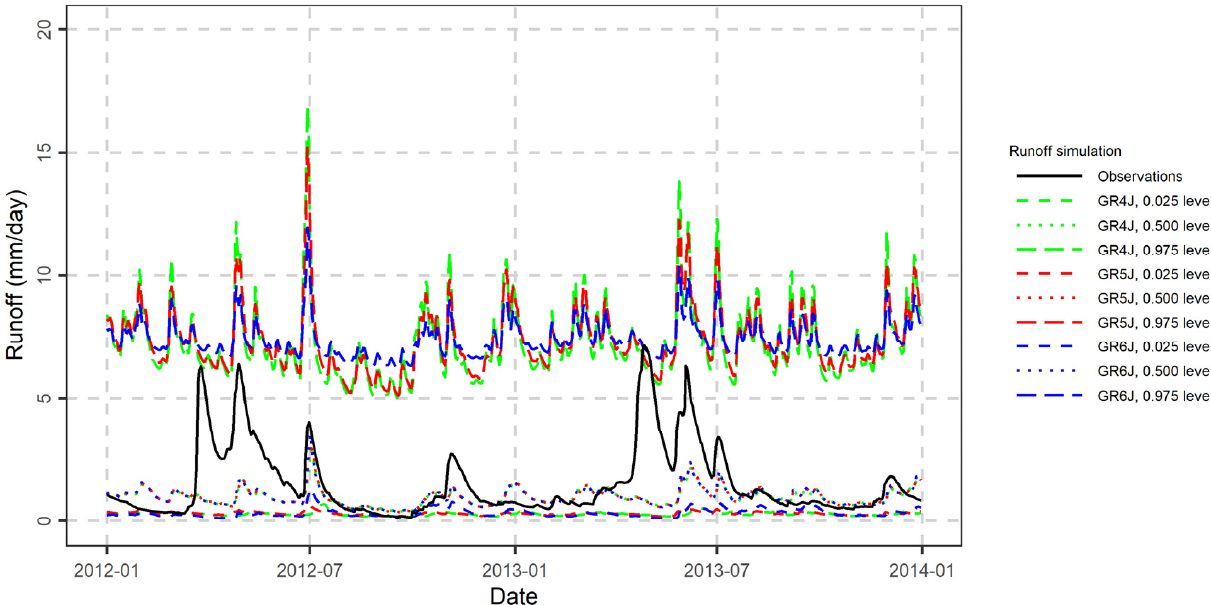
Figure 3. Illustration of observed streamflows and quantiles predicted by the GR4J, GR5J and GR6J hydrological models at the levels a ∈ {0.025, 0.500, 0.975} for a two-year period at an arbitrary river basin.